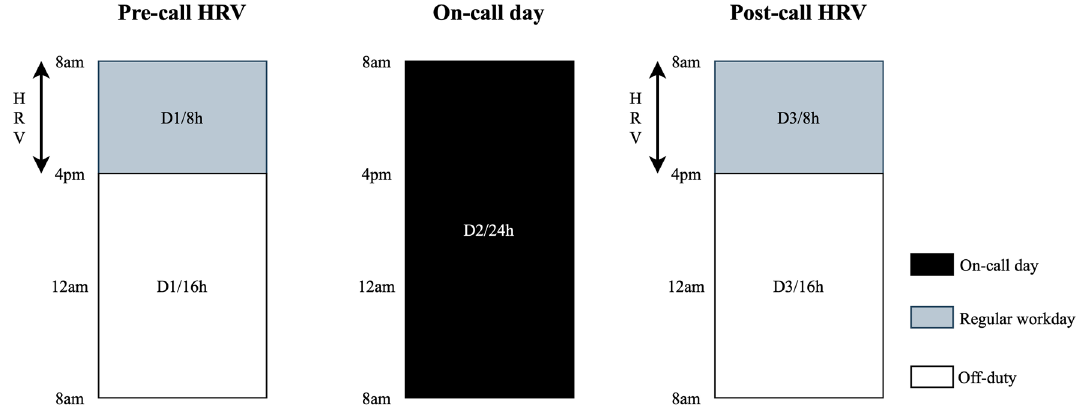
Figure 1. Flow of study comparing 8-h HRV on the day before and after on-call